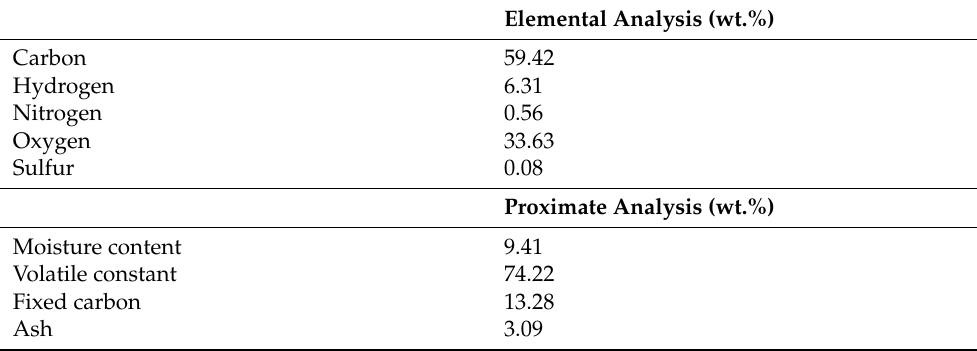
Table 1. Elemental and proximate analysis of waste coconut